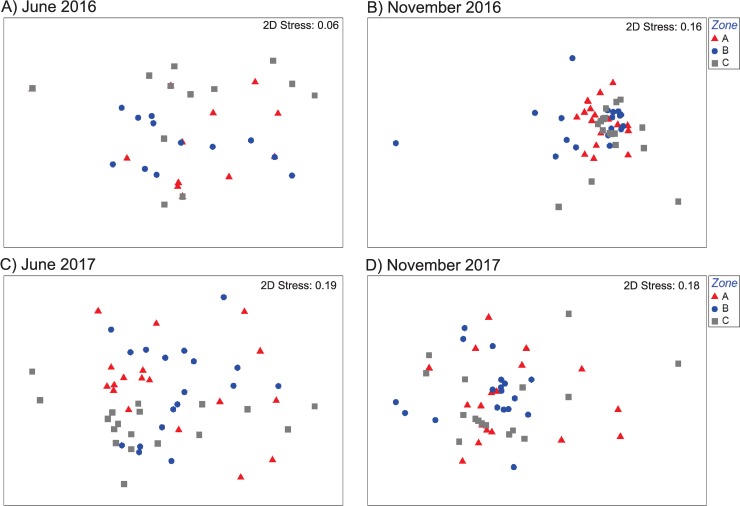
nMDS ordinations of invertebrate communities.nMDS ordination of invertebrate community structure in samples from zone A (red triangles), zone B (blue dots), and zone C (gray squares) of the Puerto Morelos reef lagoon in June 2016 (A), November 2016 (B), June 2017 (C) and November 2017 (D). Analyses were done using square-root transformation of species’ abundances and Bray-Curtis similarity. Each symbol denotes a quadrat.